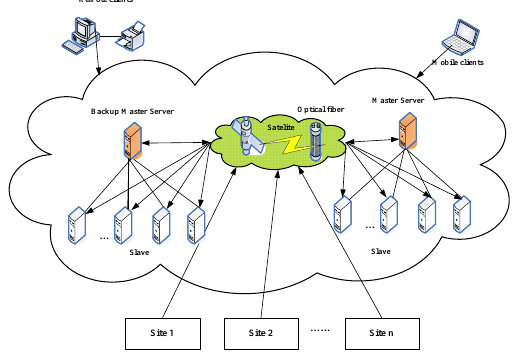
Figure3. The structure of SCADA system based on cloud